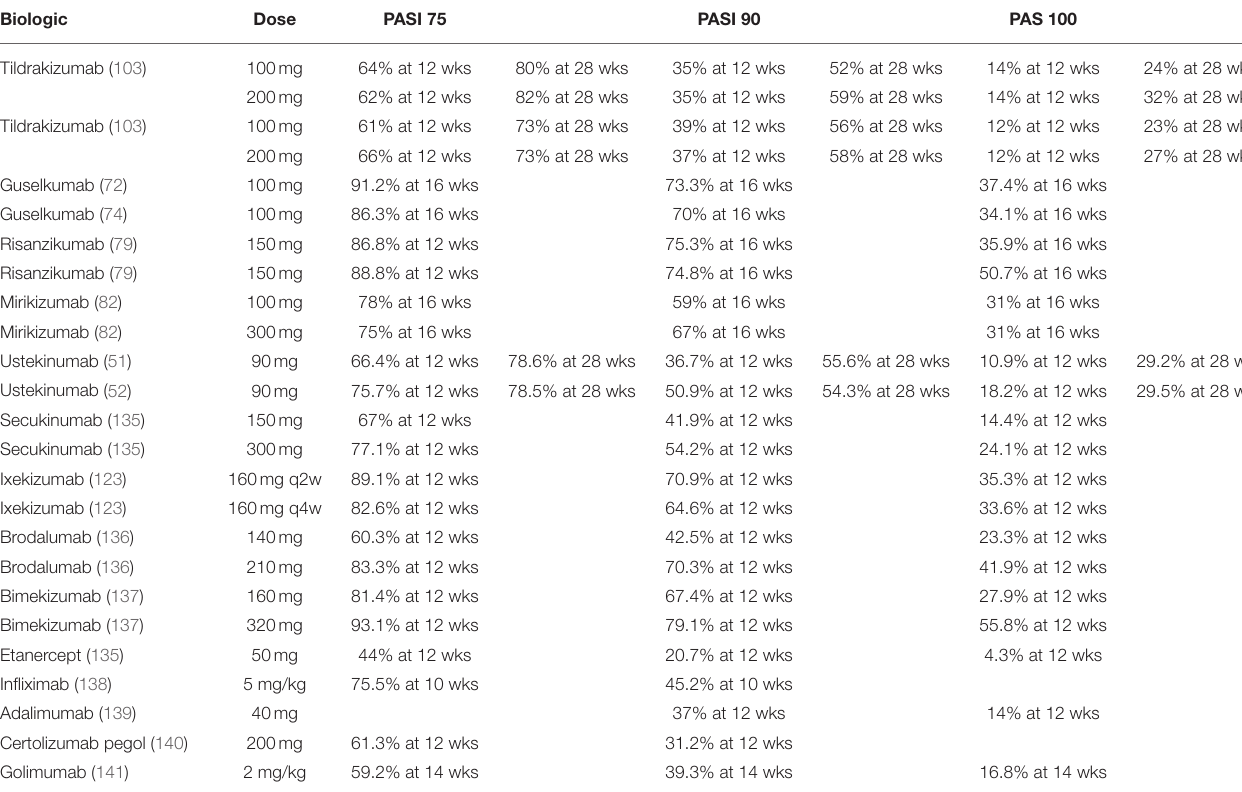
TABLE 4 | Summary of PASI75, 90, and 100 responses evaluating biologic agents in Phase III clinical trials for IL-23, IL-23/12, IL-17, and TNF- α inhibitors.